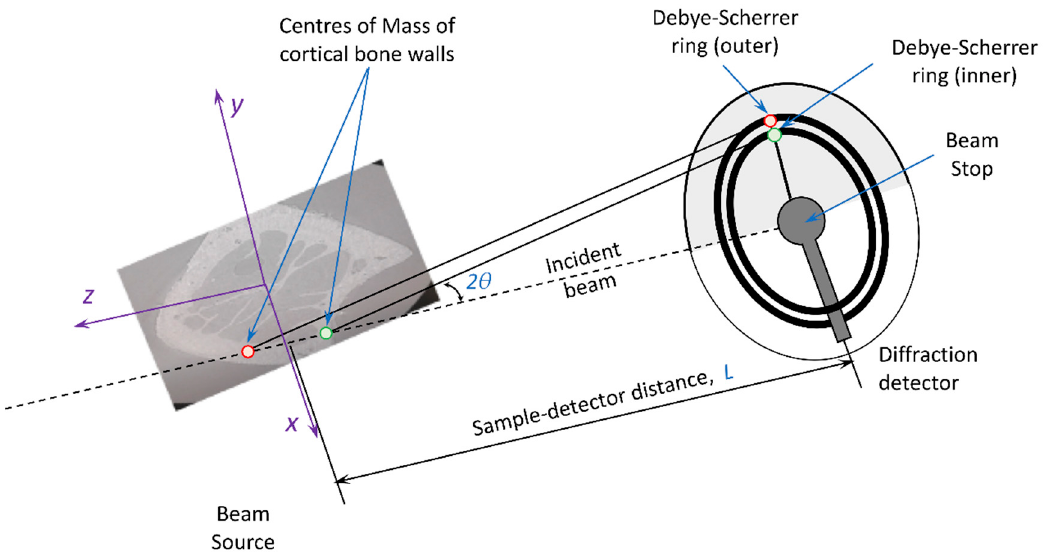
Figure 9. Illustration of the effect of bone sample cross-sectional shape on the radial ring position on the 2D diffraction detector.